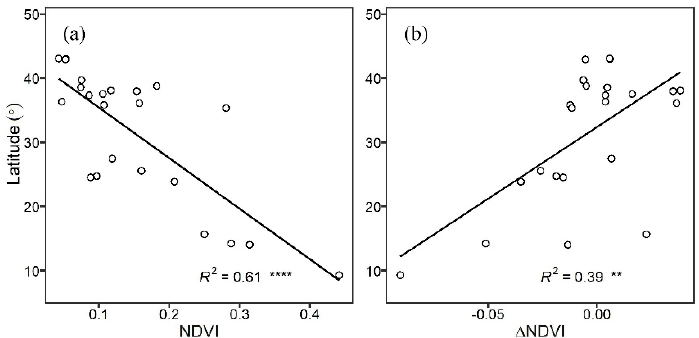
Figure 8. The relationships between latitude with ( a ) NDVI and ( b ) ∆ NDVI. The solid lines are the linear regression lines; ns, *, **, ***, and ****: statistically significant at p > 0.05, p < 0.05, p < 0.01, p < 0.001, and p < 0.0001 levels.